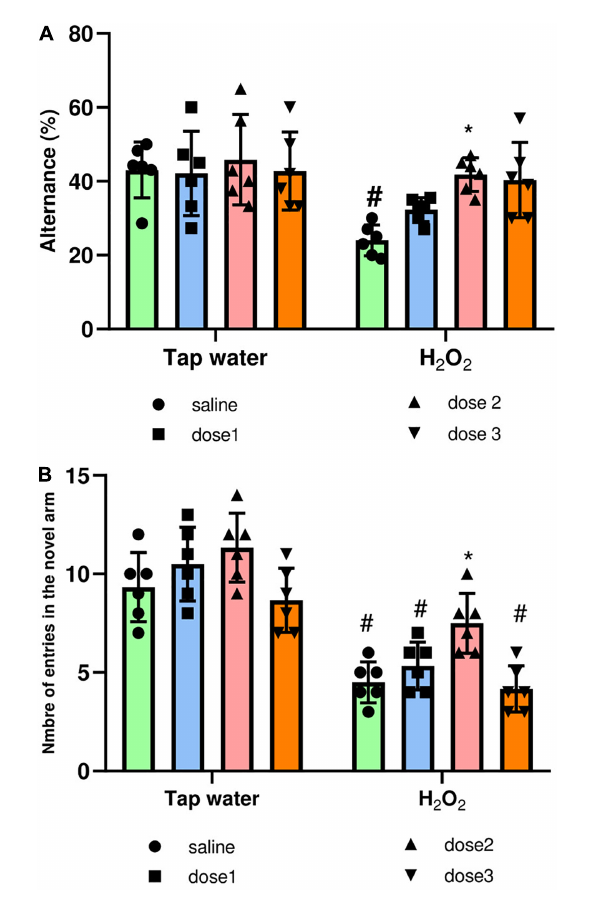
FIGURE7 Effect of the interaction between the extract treatment and the exposure to H 2 O 2 on short-term memory assessed by the Y-maze test. (A) Presents the percentage of alternance as an indicator of the spatial working memory. (B) Presents the number of entries in the novel arm as an indicator of spatial reference memory. The results were presented as mean ± SD ( n = 6). Data were analyzed by Two-ways ANOVA followed by Bonferroni’s post-hoc test; * p ≤ 0.05 compared to saline group in the same treatment